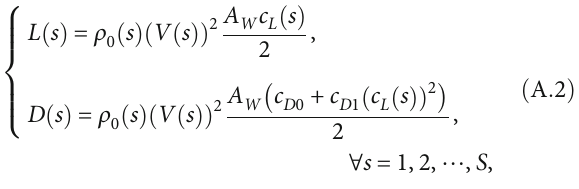
Figure 10: “ Cruise altitude and total cost ” analysis under di ff erent combinations of aircraft mass and gravity center position with standard cruise speed.